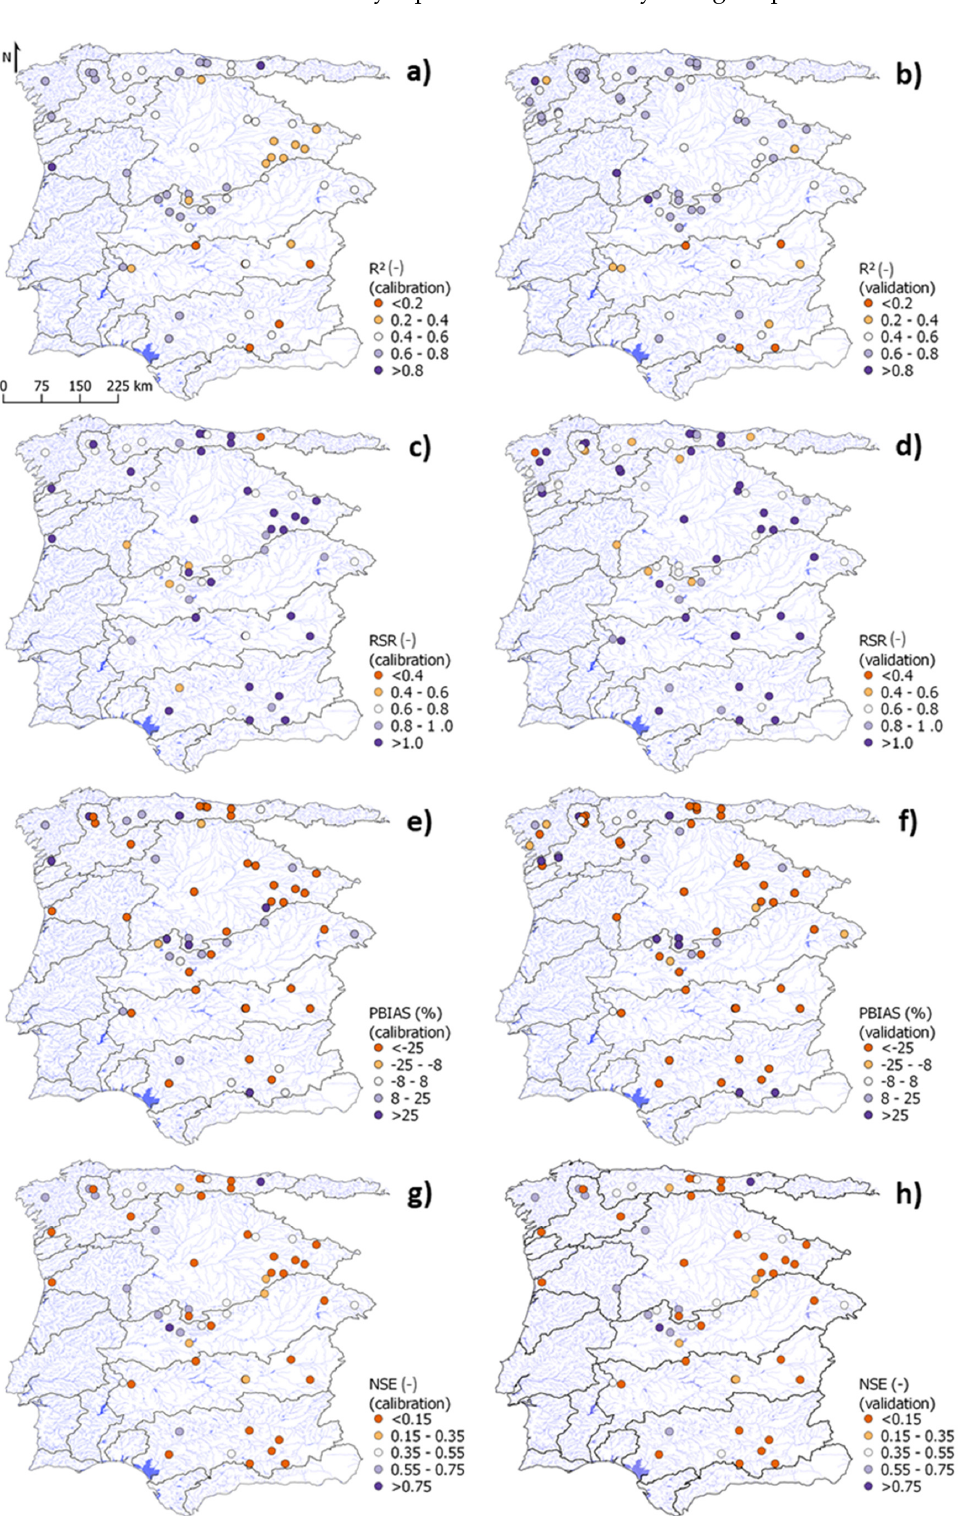
Figure 4. Statistical parameters by stations for calibration (left side) and validation (right side) periods: ( a , b ) coefficient of determination (R 2 ); ( c , d ) root mean square error-observation standard deviation ratio (RSR); ( e , f ) percentage bias (PBIAS); ( g , h ) Nash–Sutcliffe efficiency (NSE).